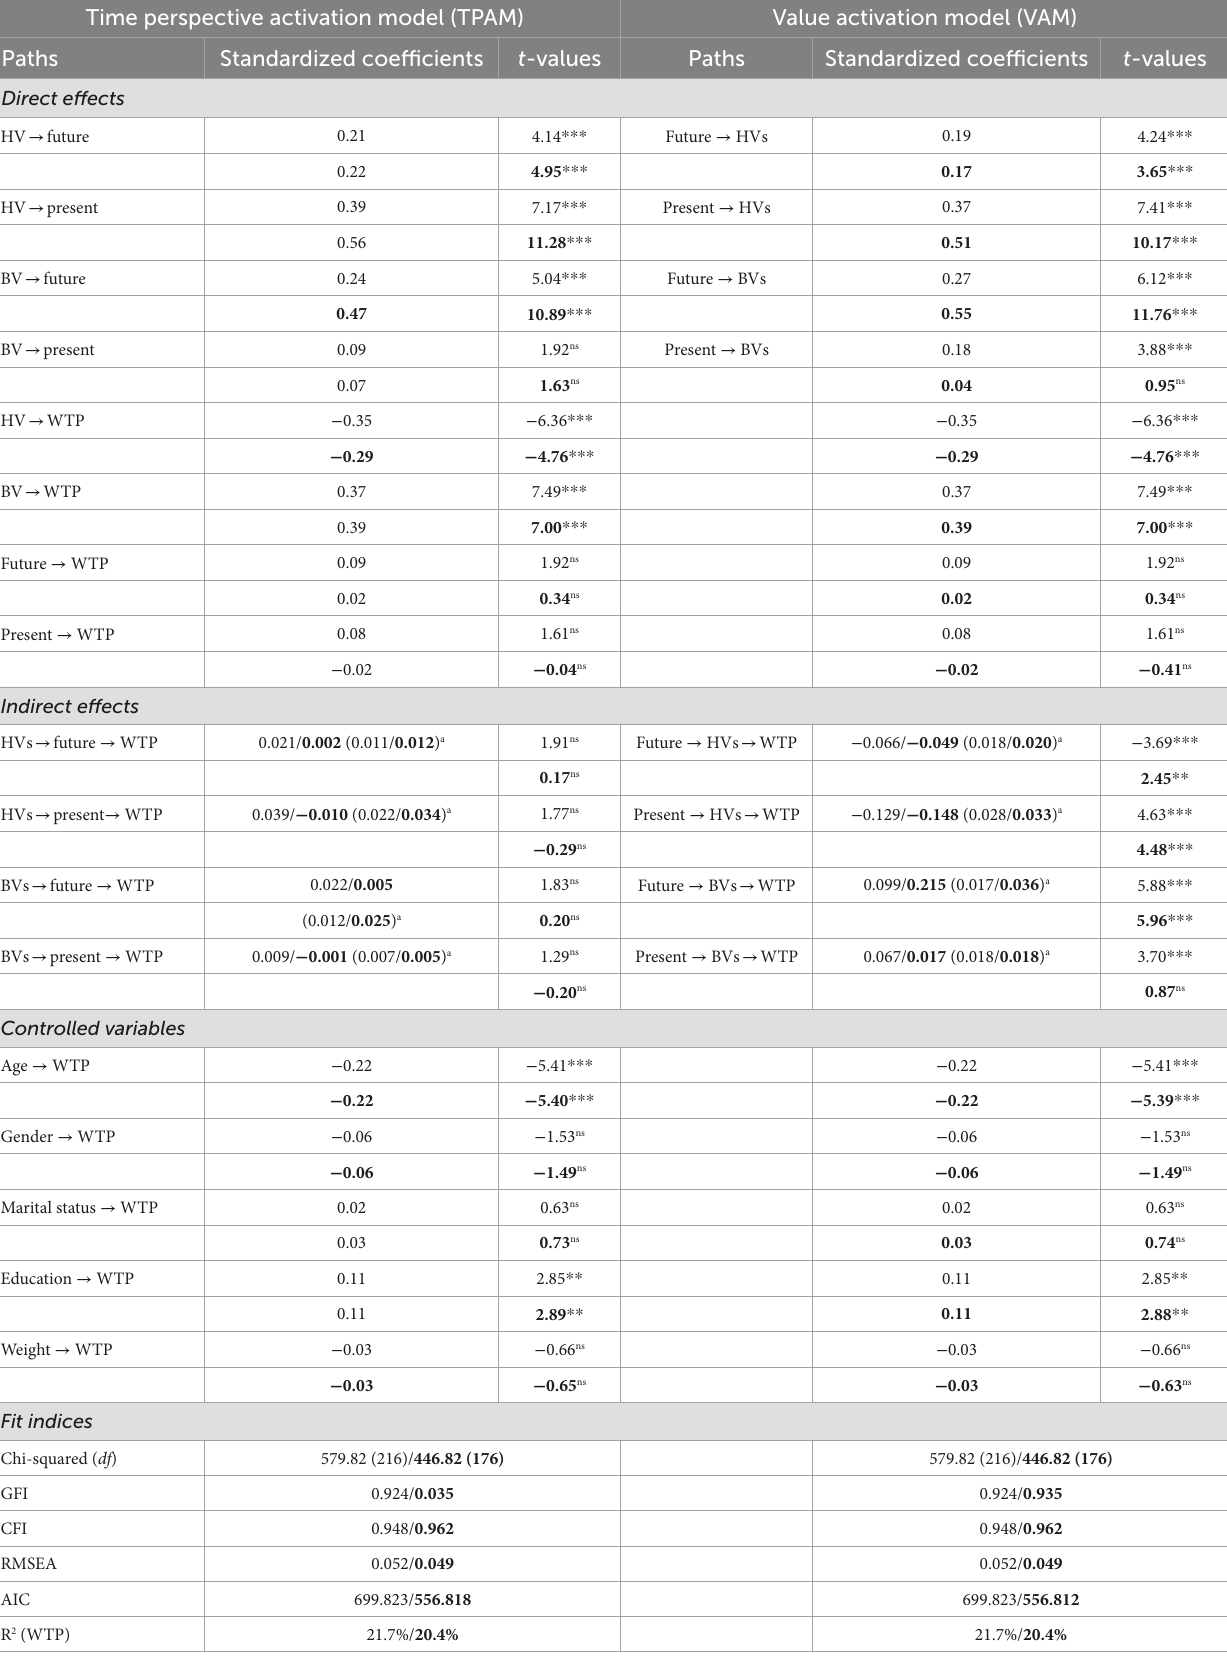
TABLE 4 Testing of structural relationships and control variables in the TPAM and VAM. Time perspective activation model (TPAM) Value activation model (VAM) Paths Standardized coefficients